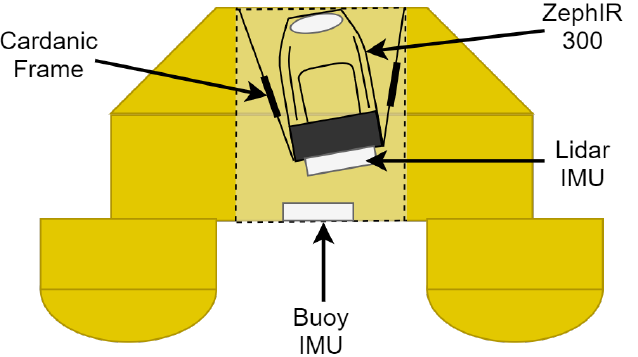
Figure 2. Instrumentation scheme of the FDWL proof-of-concept buoy used in PdP